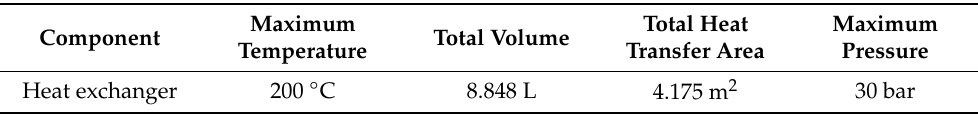
Figure 2. The pictures of ( a ) experimental setup; ( b ) the electrical load; ( c ) the circuit and ( d ) centrifugal pump. Table 1. Parameters of plate heat